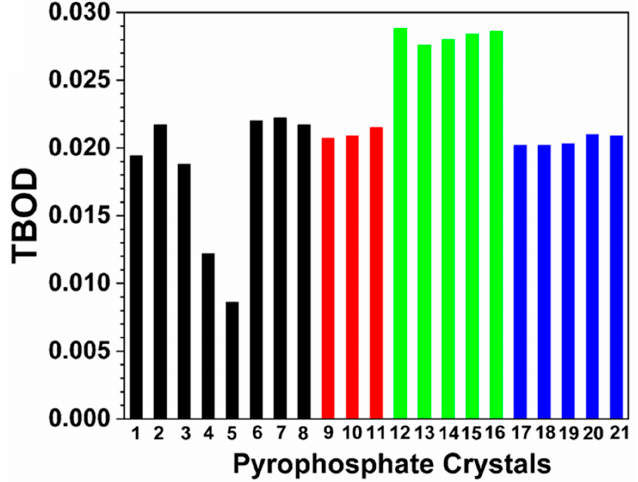
Figure 5. Distribution of TBOD for the 20 crystals. The black color is for the crystals from 1 to 8, red color is for crystals from 9 to 11, green color is for crystals from 12 to 16, and blue color is for crystals from 17 to 21. Table 3. Effective charge (Q * ) for each atom in the 21 crystals.